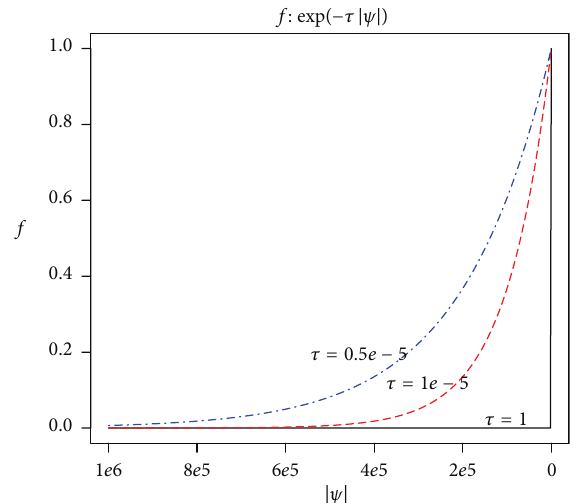
Figure 3: Function exp (−𝜏|𝜓|) and effects of different 𝜏